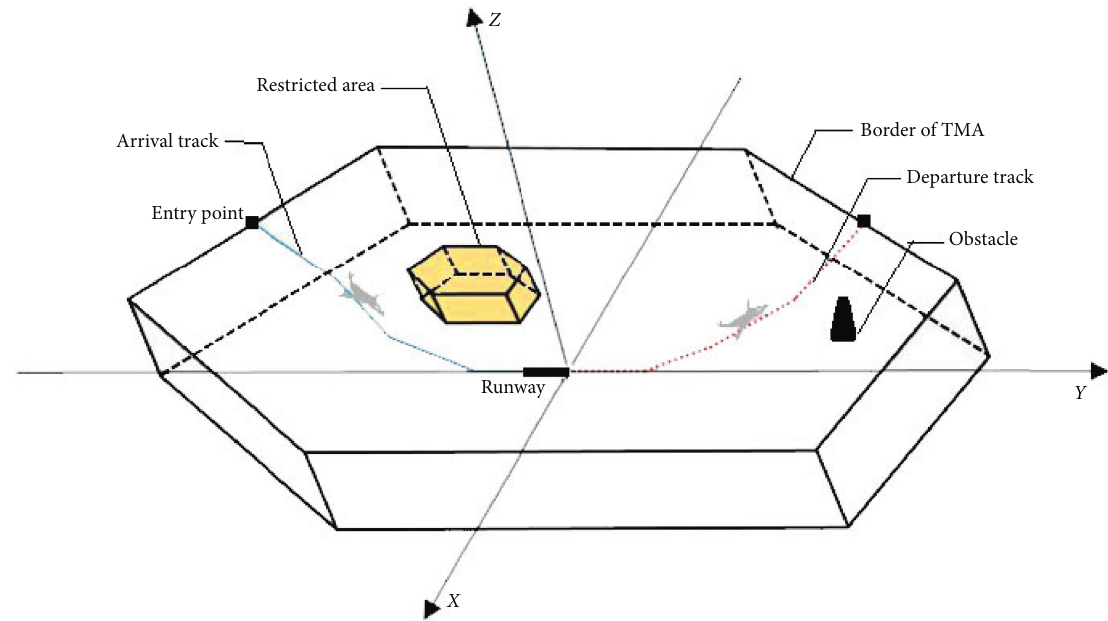
Figure 1: The model of TMA airspace.